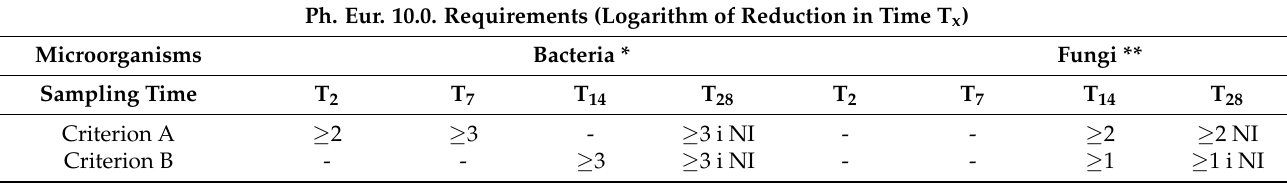
Table 5. The European Pharmacopoeia 10.0 criteria for efficacy of antimicrobial preservation.